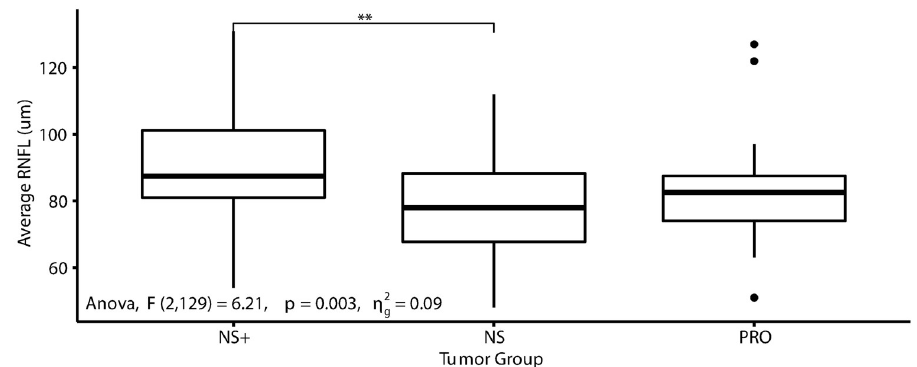
Fig 2. Average RNFL distribution of PRO and controls which were further divided into those with hyperprolactinemia as determined clinically as > 30 ng/ml (NS+) and those with normal prolactin (NS). For RNFL analysis PRO eyes n = 27, NS+ eyes n = 24, and NS eyes n = 80. RNFL did differ significantly between the groups (p-value 0.0027) using one-way ANOVA. Post Hoc (Tukey) analysis demonstrated significant difference between the NS+ and NS groups (p-value 0.0018). �� p-value < 0.01.